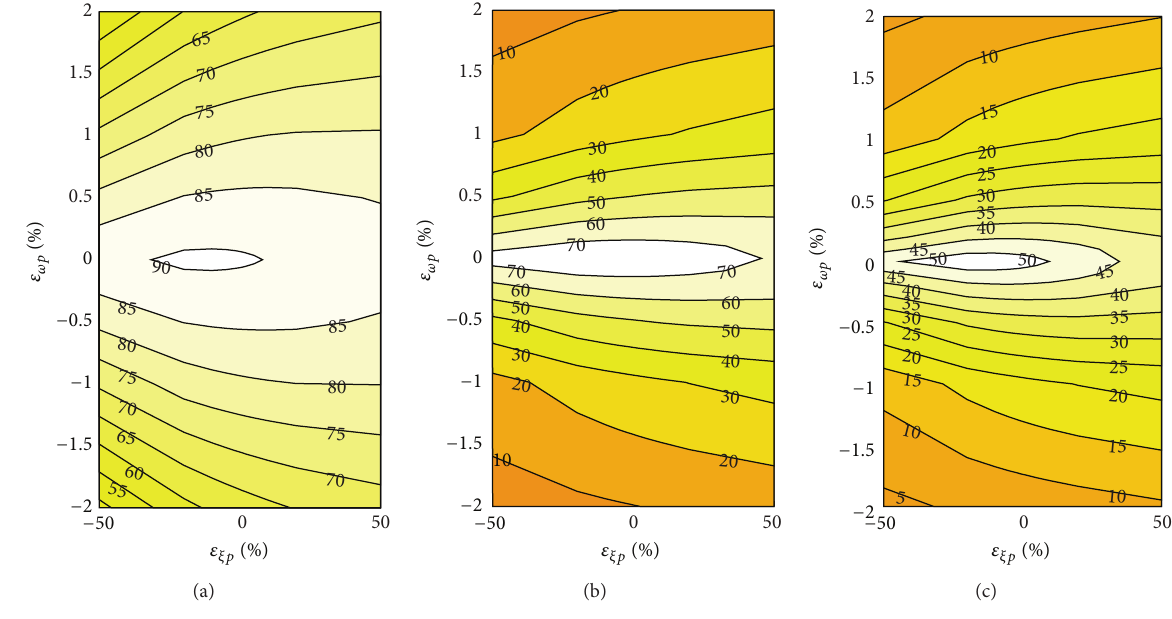
Figure 23: 𝜂 1 for case 17 (a), case 23 (b), and case 27